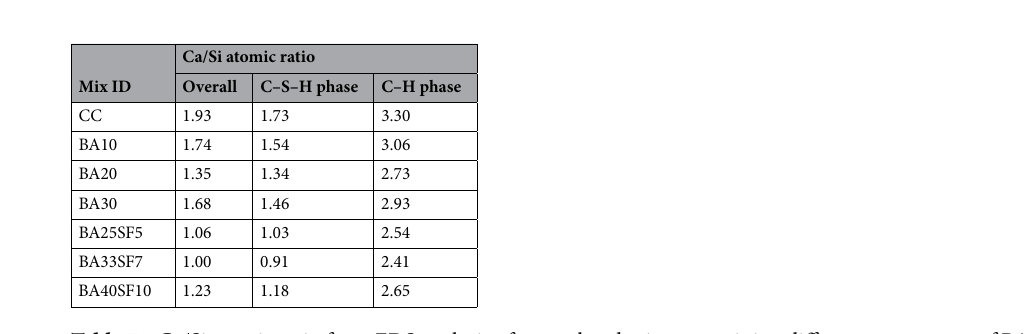
Table 7. Ca/Si atomic ratio from EDS analysis of control and mixes containing different percentages of BA alone and BA with